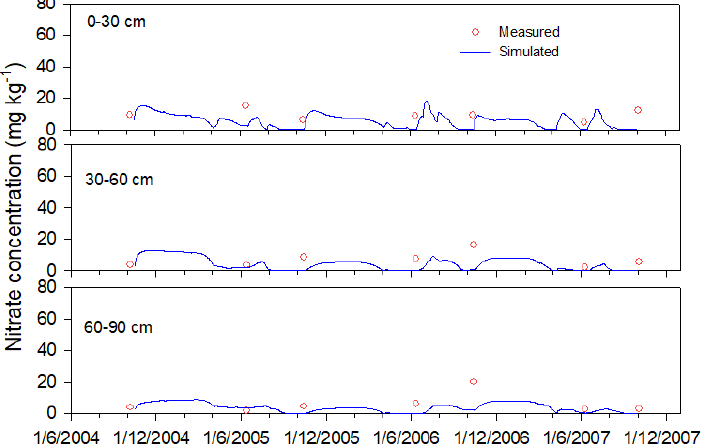
Figure 3 . Comparison of simulated and measured soil nitrate N concentration at different depths for 2H1Y_RI.